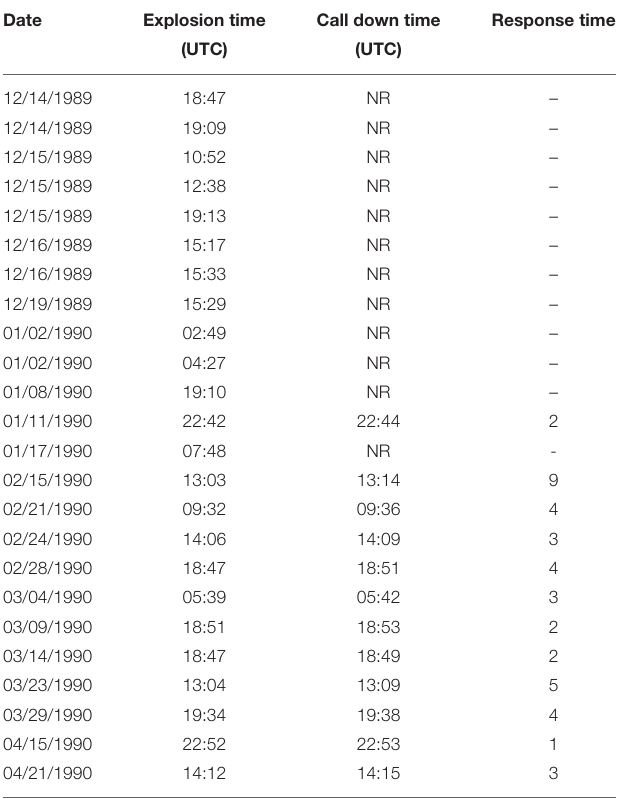
TABLE 1 | Explosions onset, call down, and response time for explosive events that occurred at Redoubt Volcano in 1989 and